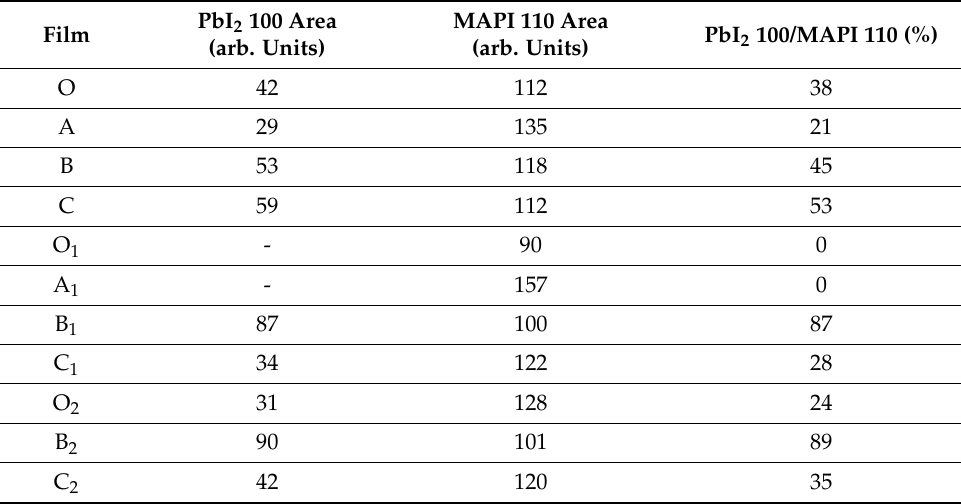
Table 2. Integrated areas of 100 of PbI 2 and of 110 of MAPI and their ratio.